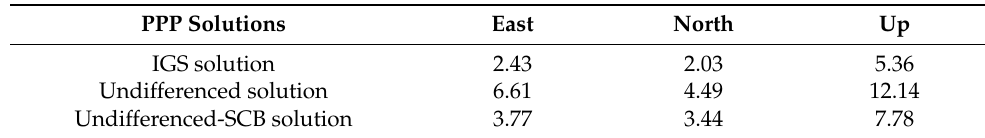
Table 5. The mean RMS (cm) for different PPP solutions when compared to IGS weekly solutions at 57 stations from DOY 031 to 037.